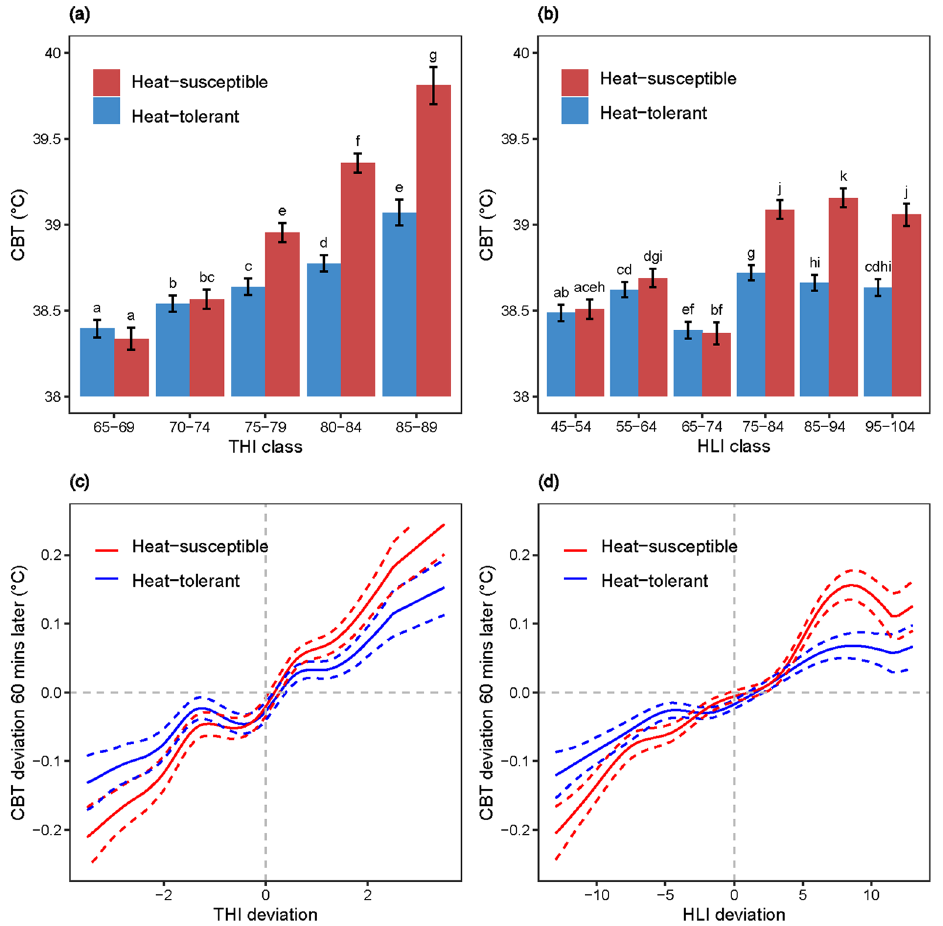
Figure 3. Core body temperature (CBT) response to different THI/HLI classes (based on raw data) ( a ) and ( b ) and to THI/HLI deviations (based on decomposed time-series data) ( c ) and ( d ) for heat-tolerant and heat- susceptible cattle. Error bars in ( a ) and ( b ) indicate standard errors of mean (SEM) and the means with different letters differ significantly. The dotted lines in ( c ) and ( d ) indicate standard errors of the CBT response curves as determined from decomposed CBT and THI/HLI time-series data.